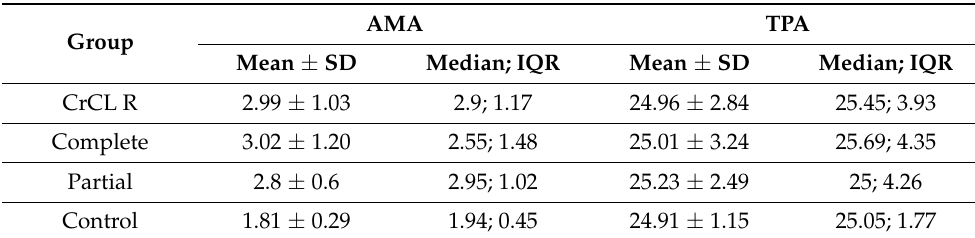
Table 5. Mean values, standard deviations (SD), median, and interquartile range (IQR) of radiographic measurements of AMA and TPA. Values are expressed in